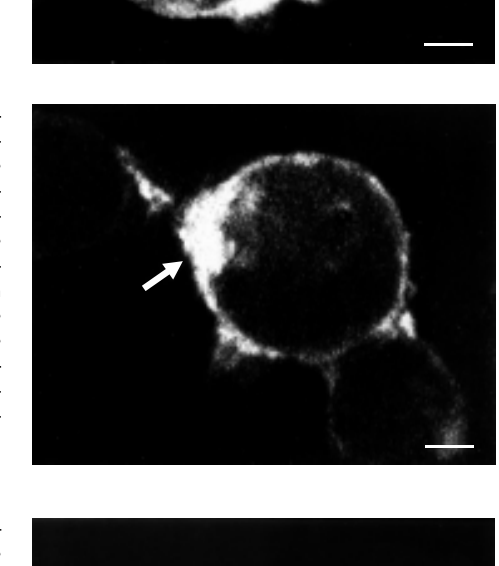
Figure 3 - Distribution of fluo-NT- labeled NT-2 receptors on the surface of an astrocyte in culture following 60-min incubation at 37 o C with 20 nM fluo-NT. In these cells, which express but do not internalize NT-2 recep- tors, surface-bound molecules form numerous polymorphic clusters. This labeling is entirely suppressed by a hypertonic acid wash. Scale bar: 20 µm.